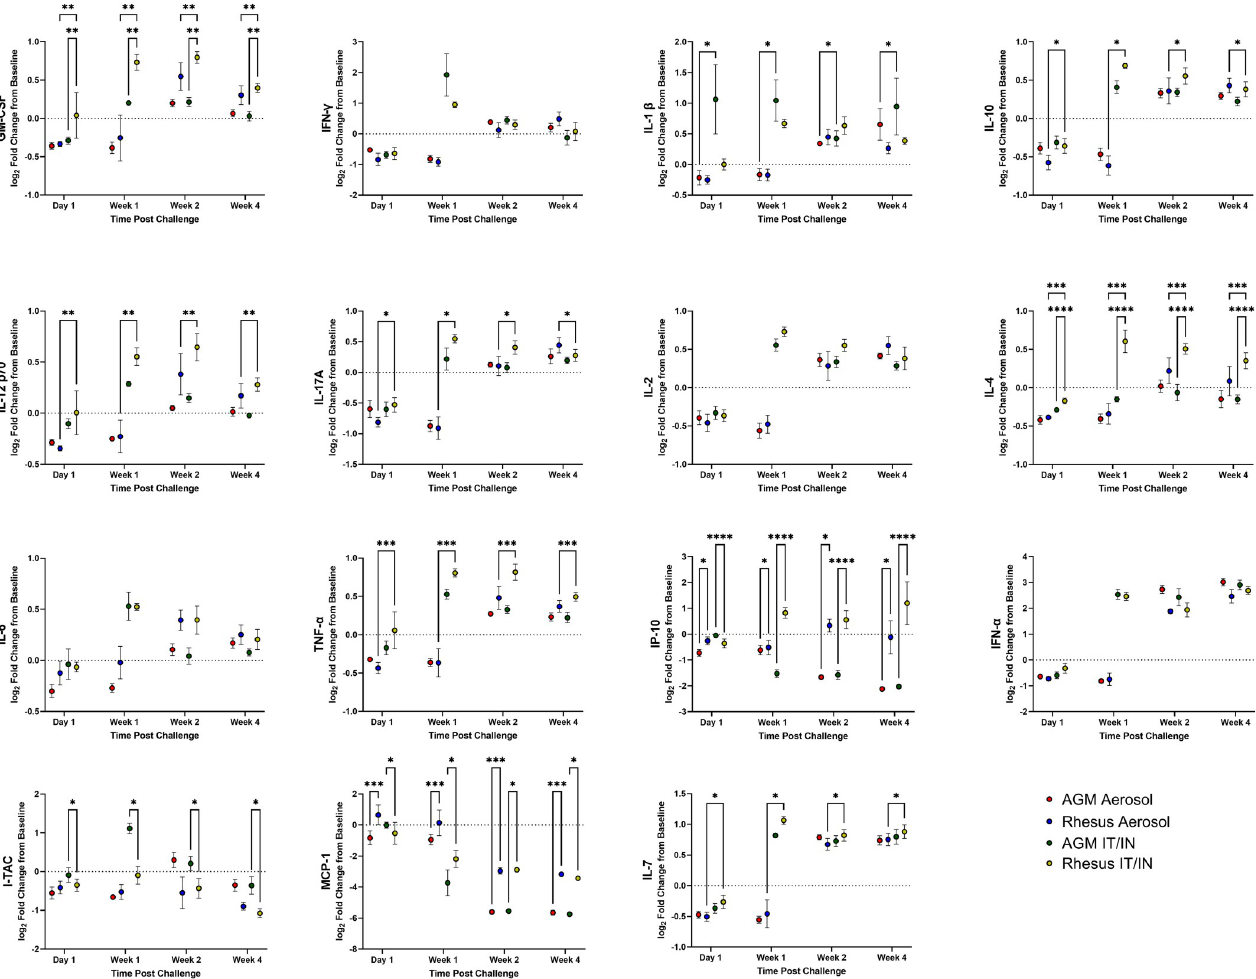
Fig 4. BAL Supernatant Cytokines post SARS-CoV-2 Challenge. Cytokines in BAL supernatant were analyzed at indicated time points post challenge. Comparisons were made with two-way ANOVA using Tukey’s multiple comparisons test. Asterisks represent significant comparisons ( � , p < 0.05; �� , p < 0.01; ��� , p <